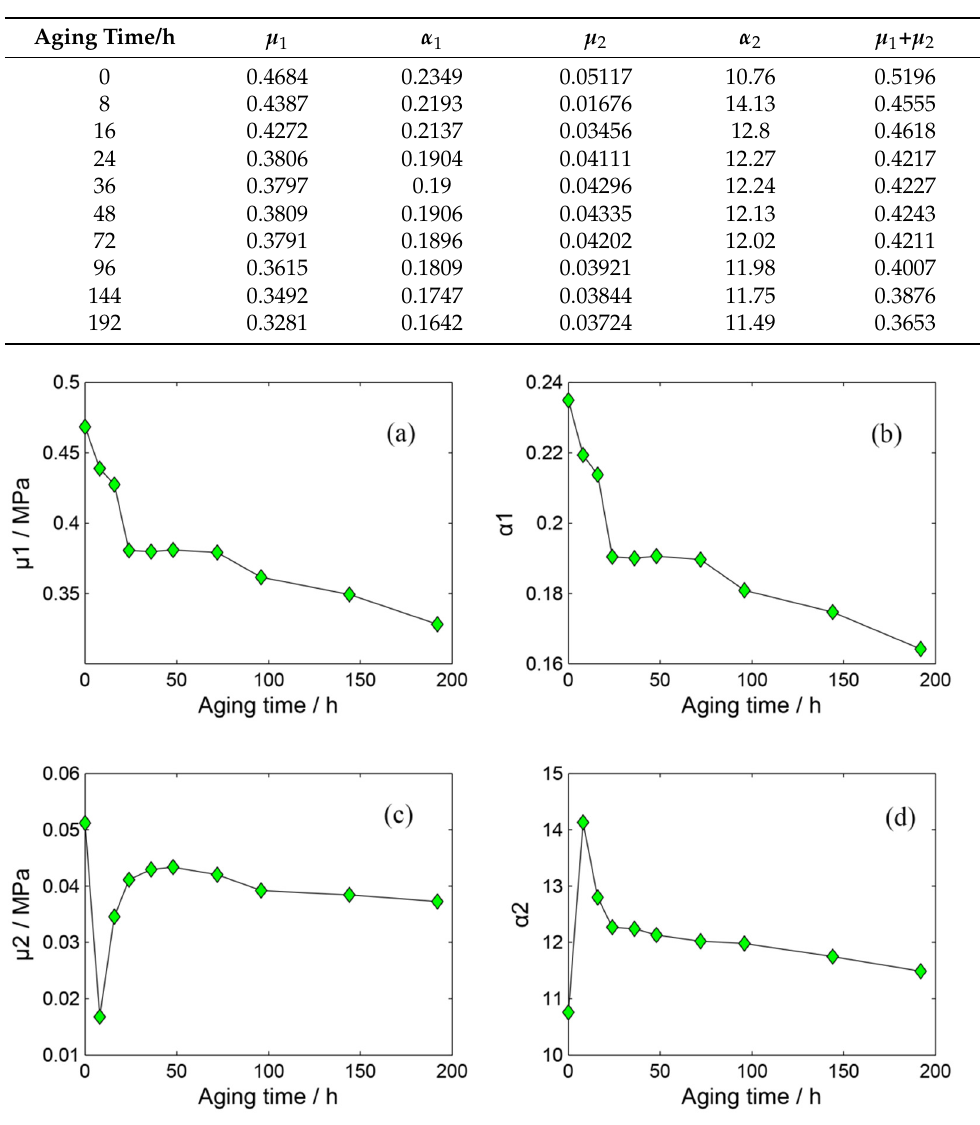
Figure 5. Variation of hyper-foam model parameters with time at different degrees of aging: ( a ) µ 1 ; ( b ) α 1 ; ( c ) µ 2 ; ( d ) α 2 .